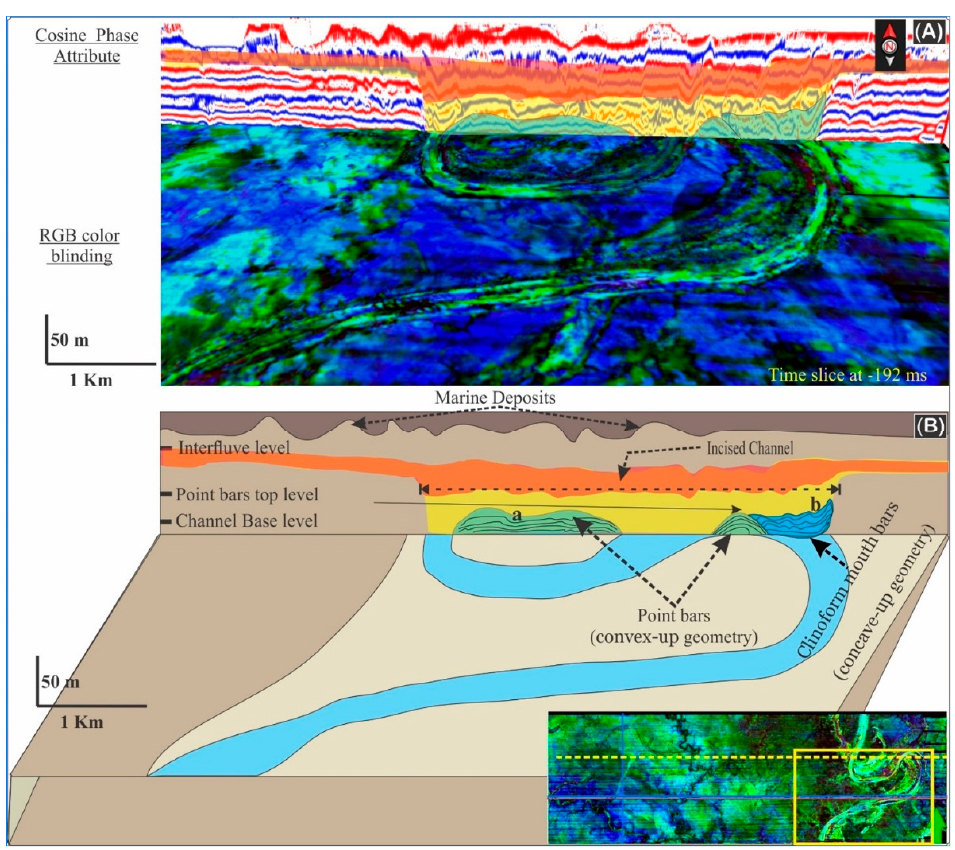
Figure 8. ( A ) chair display of the Cosine of Phase attribute cross-section with RGB seismic attribute time slice at 192 ms. Panel ( B ) represents the map view of the 2D seismic section showing the marine deposits, interfluve, point bars, incised channel, and channel belts. A convex-up thick bed (Cyan) with horizontal reflections that formed down-laps on the channel walls. The point bars deposits were covered by transgressive deposits (Yellow). The uppermost deposits (Red) cover the entire valley and lay on the interfluves’ topmost layer.